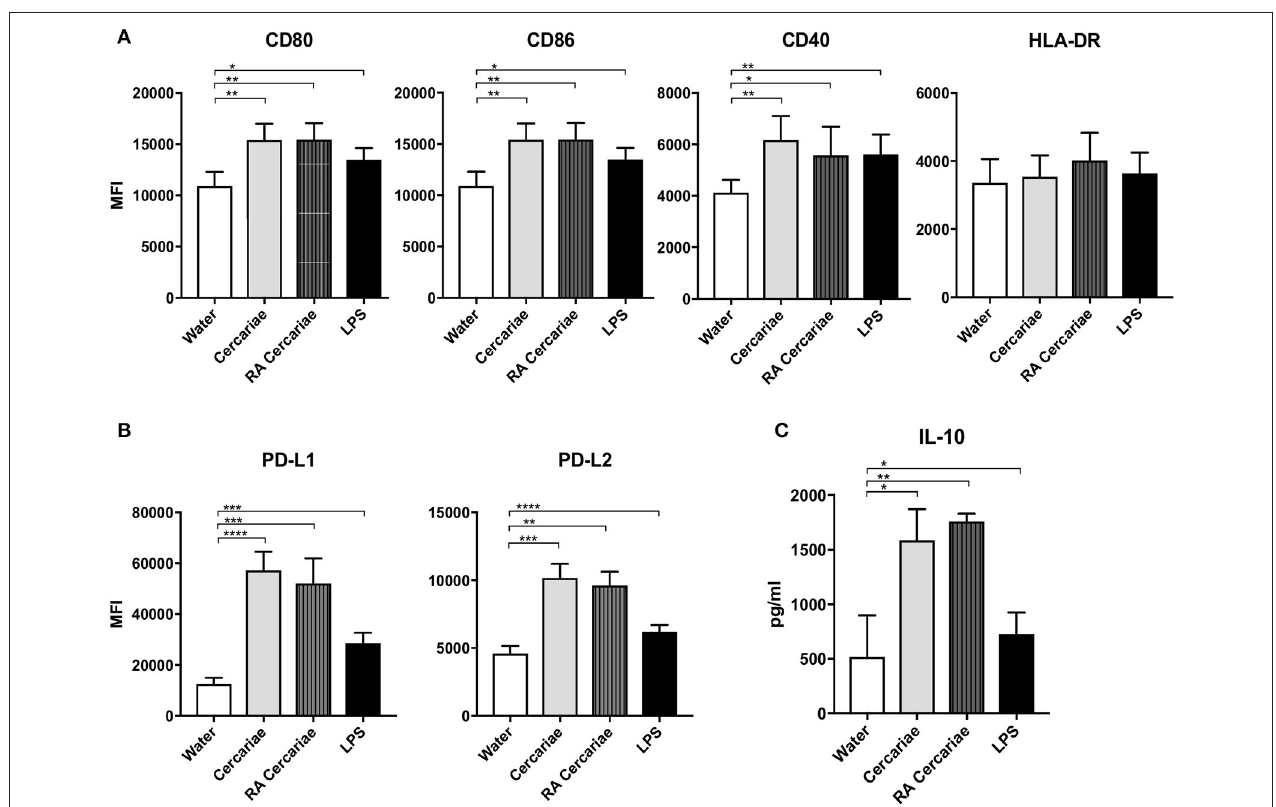
FIGURE 7 | Cercaria stimulation activates MoDCs but also induces up regulation of immunoregulatory markers PD-L1 and 2 and regulatory cytokine IL-10 production. Stimulation of MoDCs with (RA) cercariae up regulates activation markers CD80, CD86 and CD40. (A) . PD-L1 and PD-L2 up regulation after cercaria stimulation. (B) IL-10 production by MoDCs after 48h stimulation, data shown as pg/ml (C) Mean ± SEM. * p < 0.05, ** p < 0.005, *** P < 0.0005, **** p < 0.0001 using paired student’s T -test (on log transformed data for IL-10).